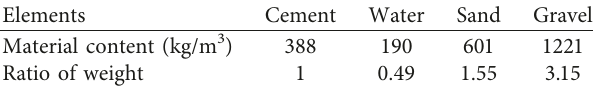
Table 1: Mix proportions of